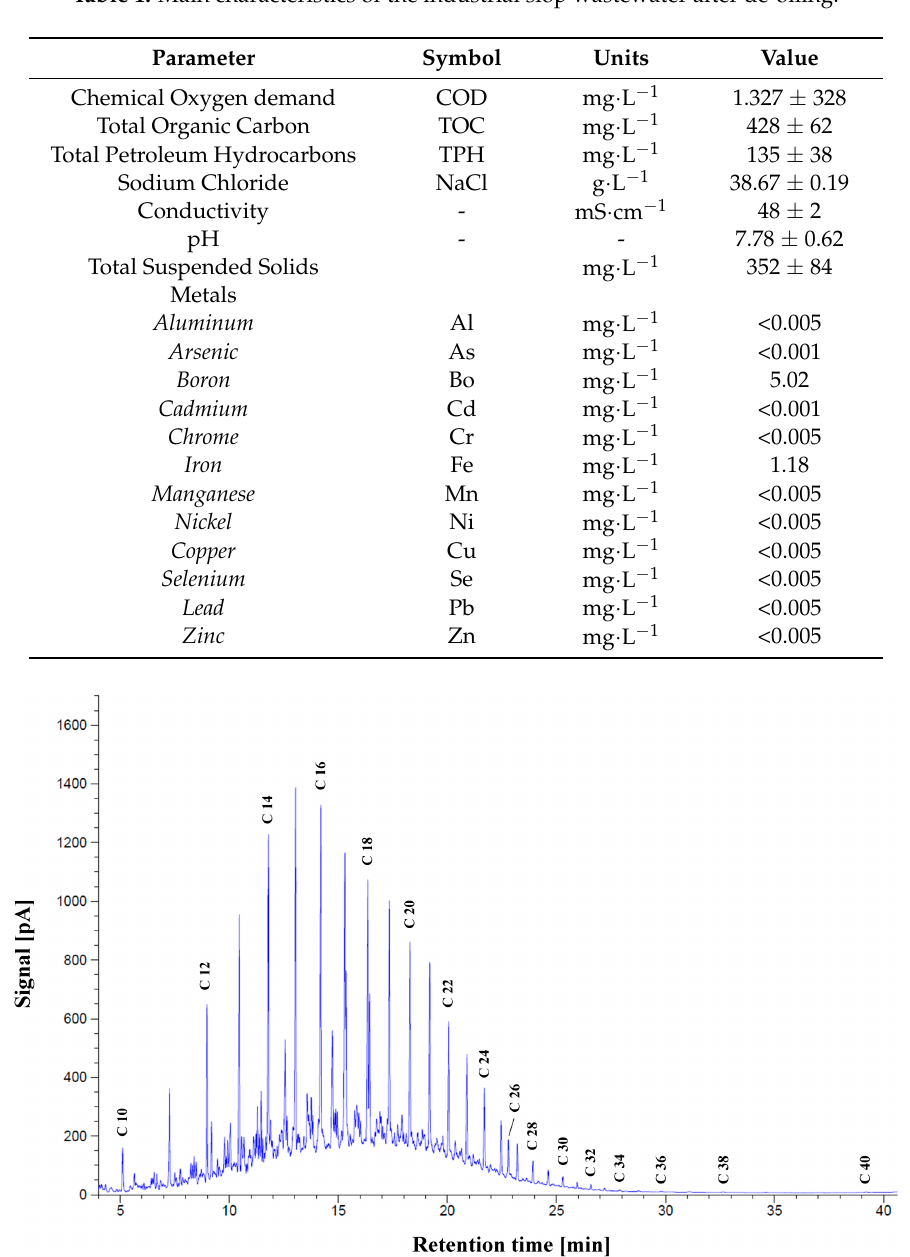
Figure 2. Chromatogram of TPH of de-oiled slop after GC-FID analysis.